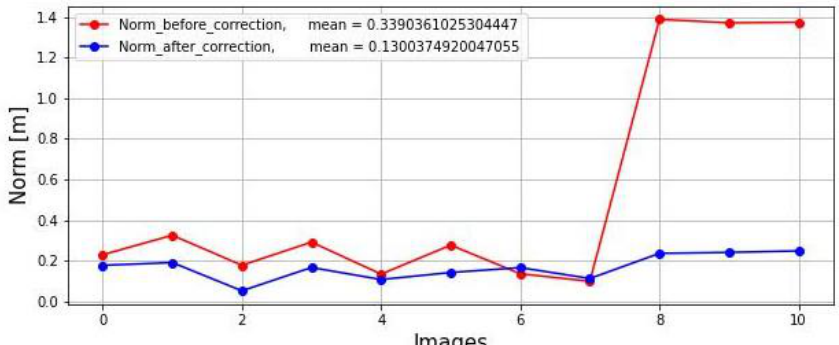
Figure 14. Shows the norm of both lidar and radar datasets before and after correction. The transformation matrix T was applied to the radar coordinates given by the corner reflector, as can be seen by the blue sphere in Figure 11. Moreover, an outdoor LRR image was taken from a parking lot with people, as illustrated in Figure 15. The colored spheres represent the radar dataset before correction, and the white spheres represent the radar dataset after correction by Equation (9).